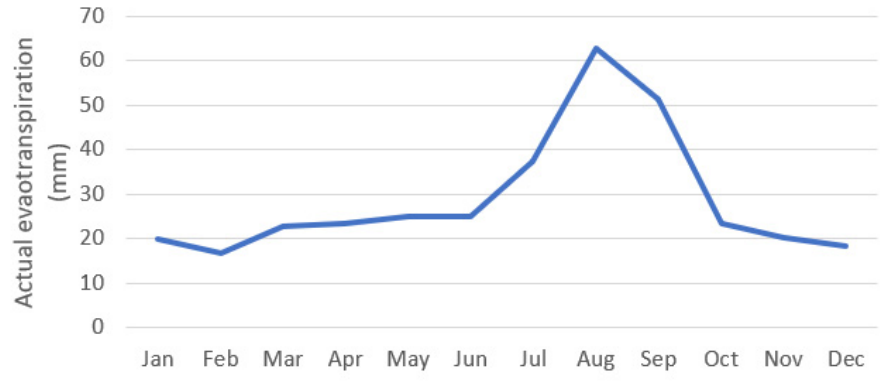
Figure 8. Actual mean evapotranspiration at a point upstream of Embameder station.